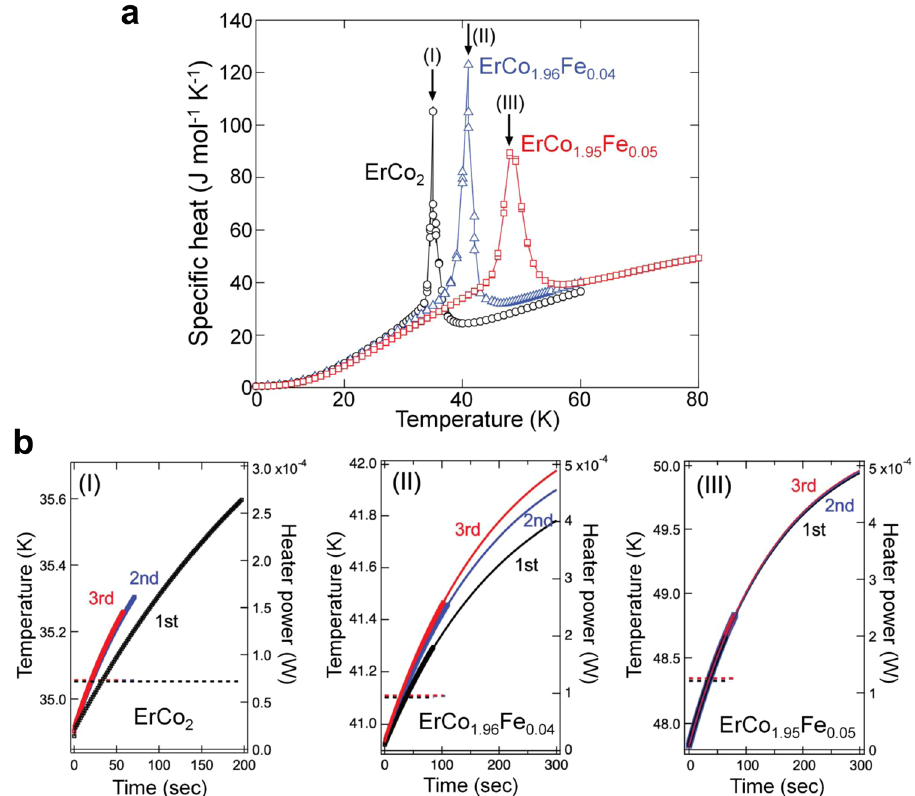
Fig. 4 Analysis of the latent heat involved with fi rst-order phase transition. a Temperature dependence of the speci fi c heat measured by the thermal relaxation method for ErCo 2 (black), ErCo 1.96 Fe 0.04 (blue) and ErCo 1.95 Fe 0.05 (red) alloys. b Time evolution of the sample temperature obtained using the relaxation method at the temperature where each sample shows a peak anomaly indicated by arrows (I), (II), and (III) in a . The dashed lines denote heat power for each measurement (1 st (black), 2 nd (blue) and 3 rd (red) measurements) in b